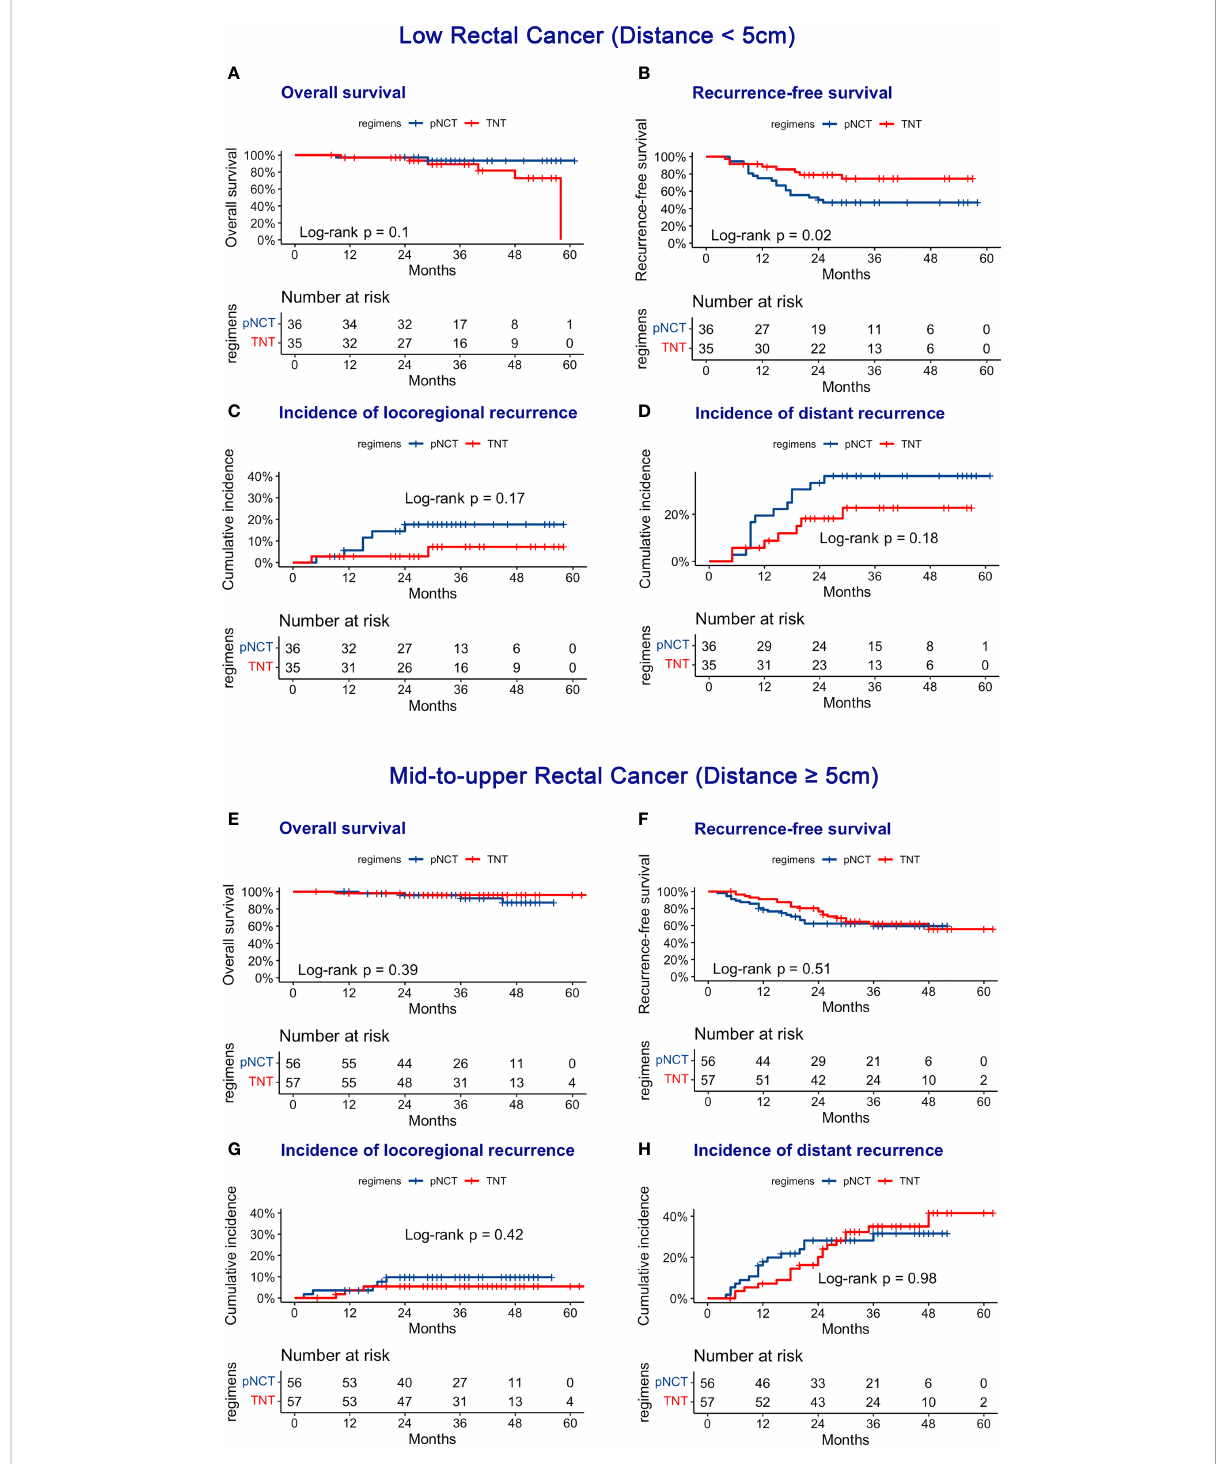
FIGURE 4 Oncologic Outcomes of pNCT and TNT in subgroup. Subgroup was divided according to the distance between tumor and anal verge. (A) Overall survival (B) Disease-free survival; (C) cumulative incidence of locoregional recurrence; (D) cumulative incidence of distant metastases in low group (distance <5 cm). E Overall survival (F) Disease-free survival; (G) cumulative incidence of locoregional recurrence; (H) cumulative incidence of distant metastases in mid-to-upper group (distance ≥ 5